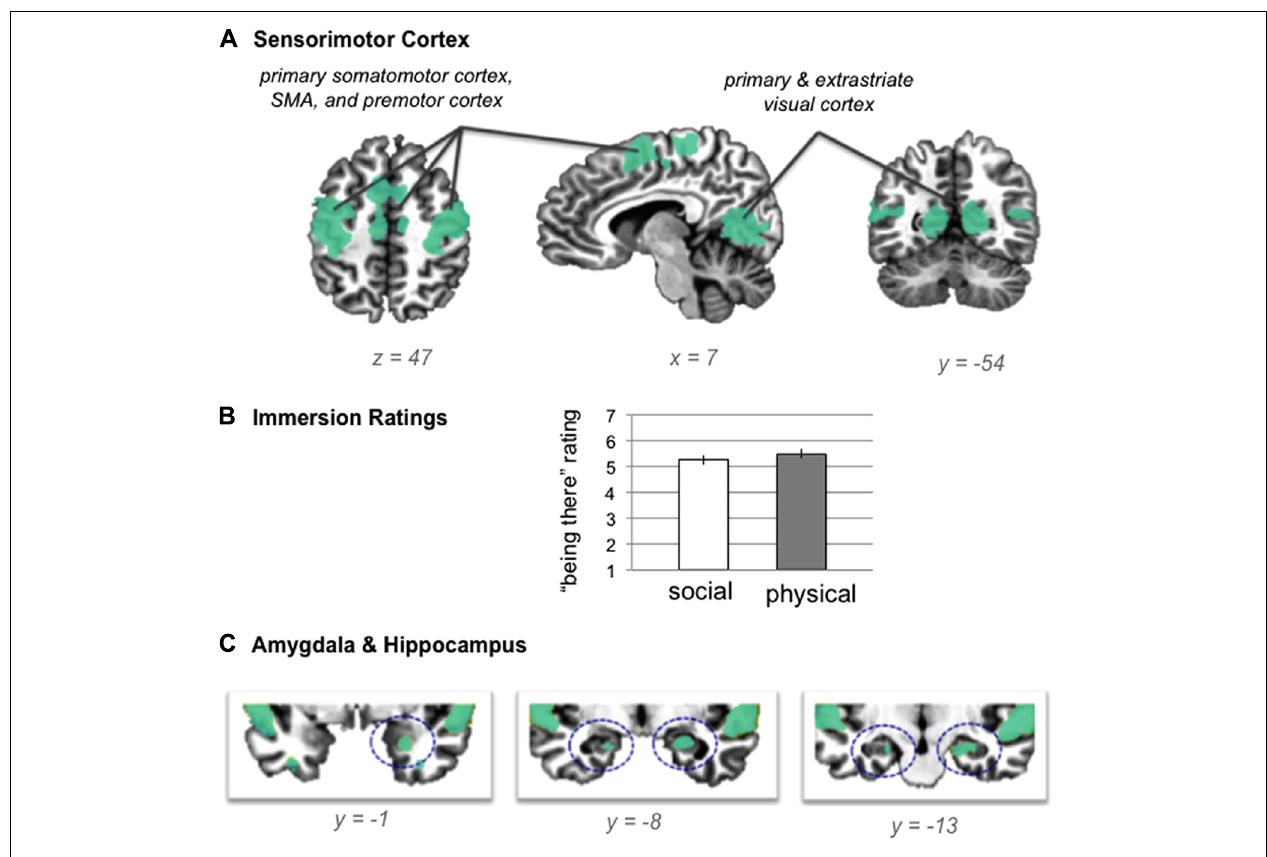
FIGURE 2 | (A) shared neural activity during social evaluation and physical danger situations in sensorimotor cortex (revealed by the conjunction analysis in which each situation was compared to the “no sound” baseline) (B) self-